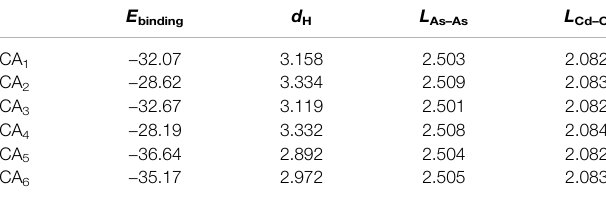
TABLE 1| Thebindingenergy ( E binding ,meV/Å 2 ),interfacedistance( d H ,Å)andthe bond length ( L , Å) of the different stacking style CdO/As